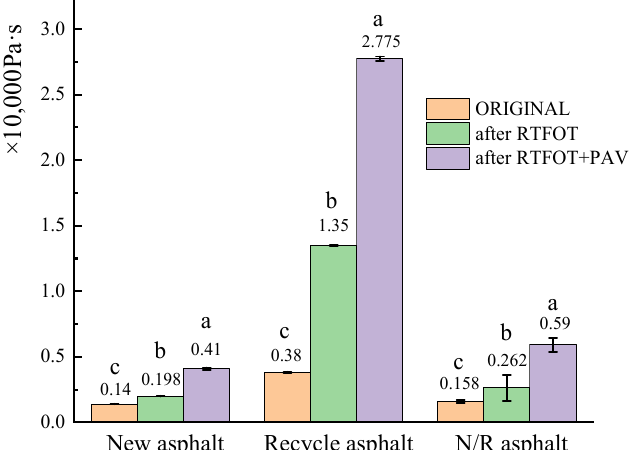
Figure 1. Dynamic viscosity of the three asphalts at 120 °C before and after aging. a, b, c symbols on each column represent significant difference at 0.05 level.